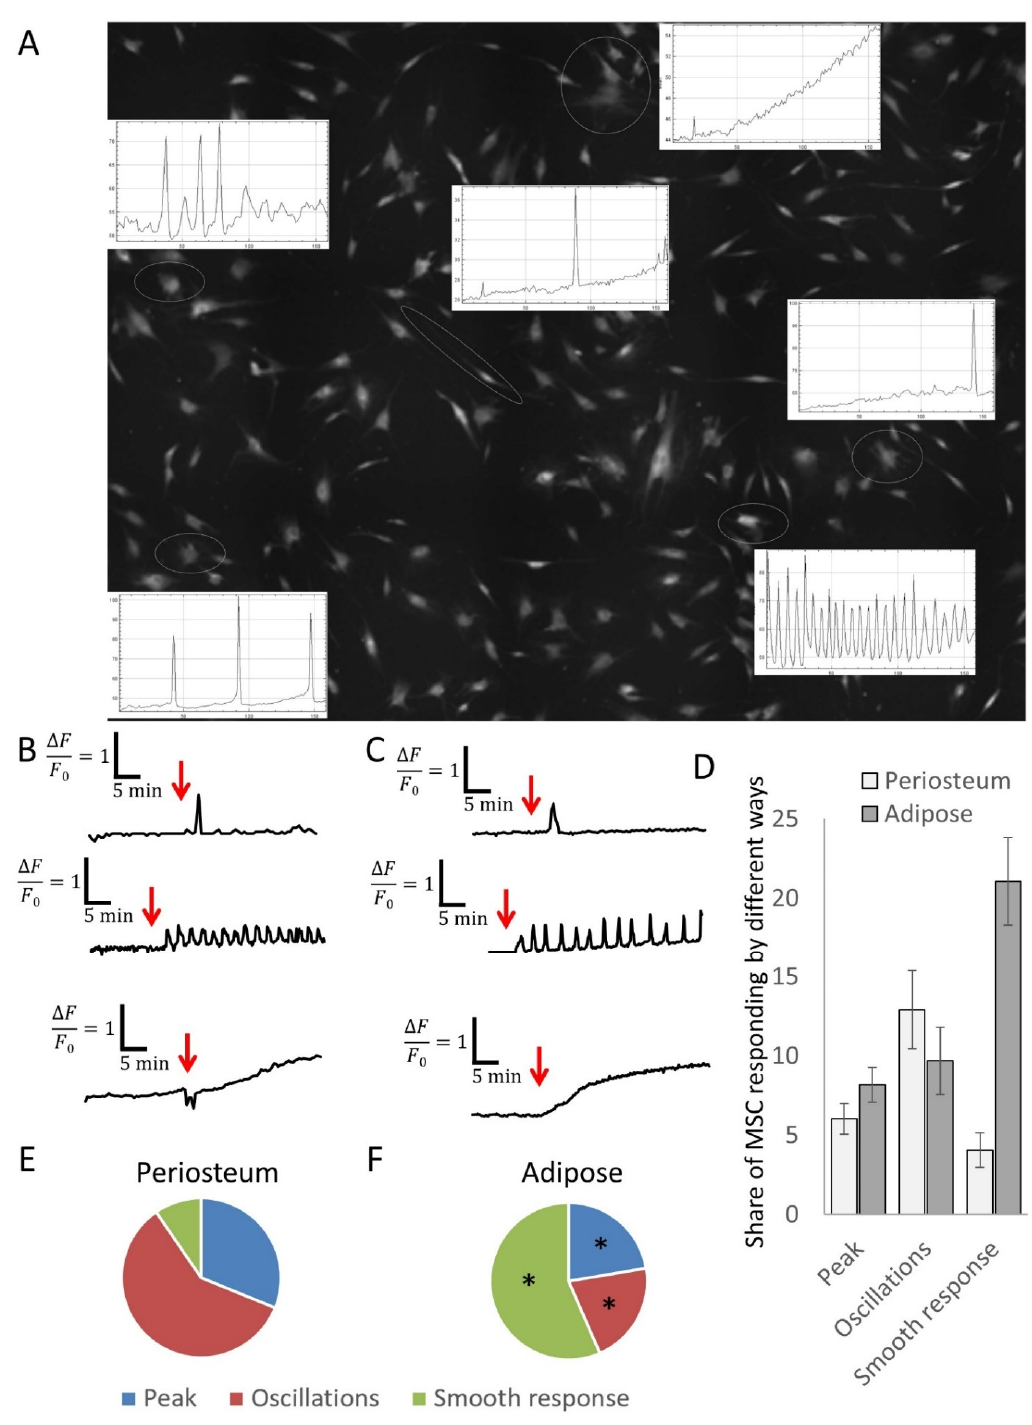
Figure 4. Calcium signaling in MSCs derived from adipose tissue and periosteum. ( A ) Representative snapshot of MSCs stained with Fluo-8 dye with graphs of responses of the single cells. Individual cells of the same population of adipose tissue ( B ) and periosteum ( C ) responded in one of three ways: single calcium peak, calcium oscillations, or a smooth increase in intracellular calcium level. ( D ) Number of adipose-derived and periosteum-derived MSCs responding in the different ways. ( E , F ) Share of MSCs responded in the different ways among all responding cells in MSCs from adipose tissue ( E ) and periosteum ( F ). Mean ± SE, n = 6–7 different donors; * p < 0.05 versus corresponding periosteum